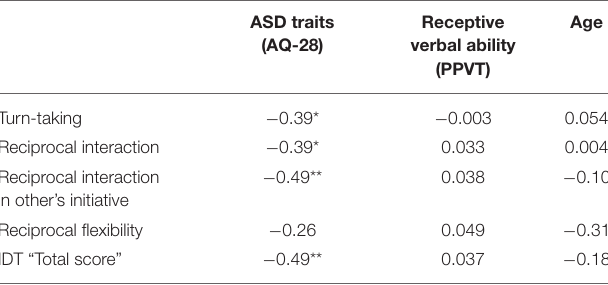
= TABLE 3 | Correlations between IDT scores, AQ-28, PPVT and age in the total p group.